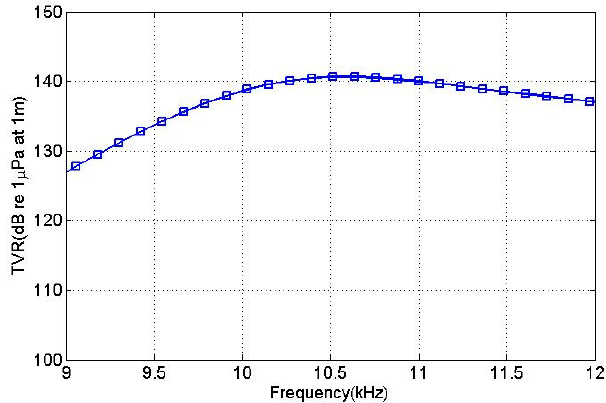
Figure 8. The transmitting voltage response of the transducer in water.